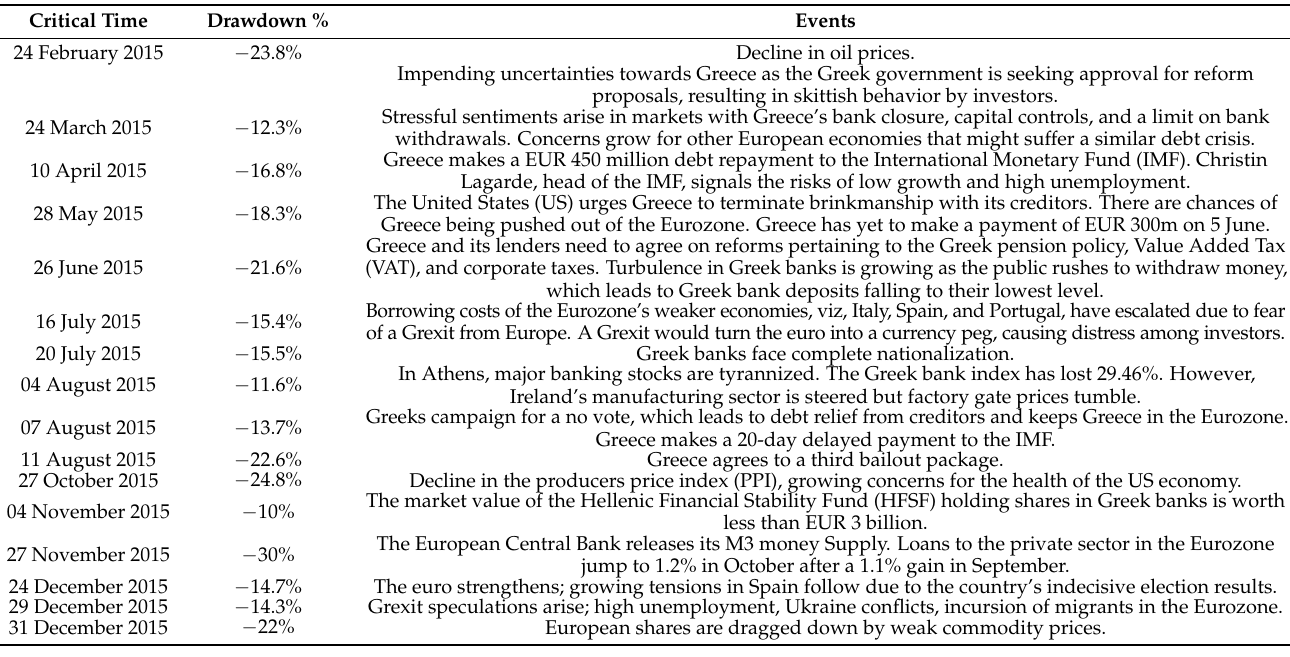
Table 7. Linking international events with the double-digit